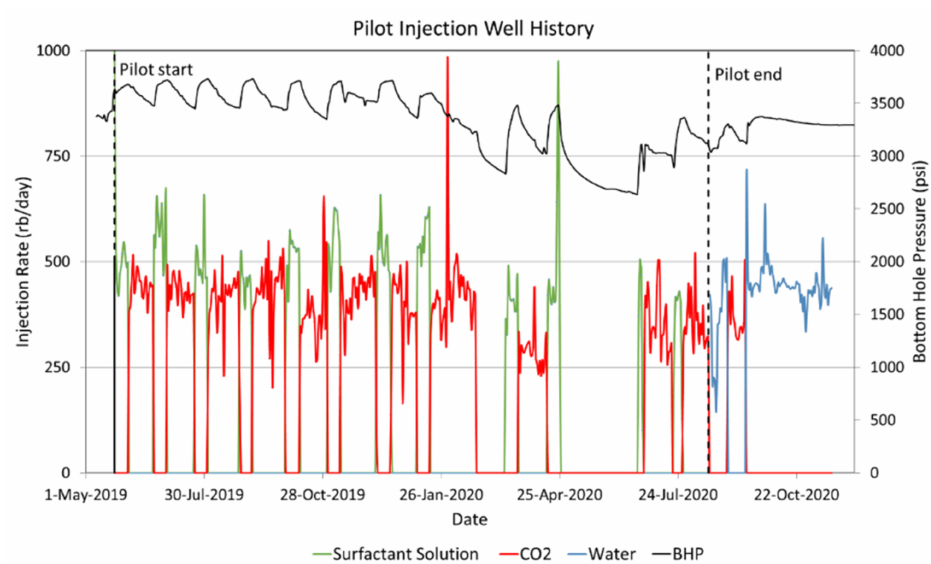
Figure 1. Observed injection rates and bottom hole pressure (BHP) during the foam pilot. The red curve corresponds to CO 2 injection, the green curve to surfactant solution injection, and the blue to water injection. The BHP is shown as the black